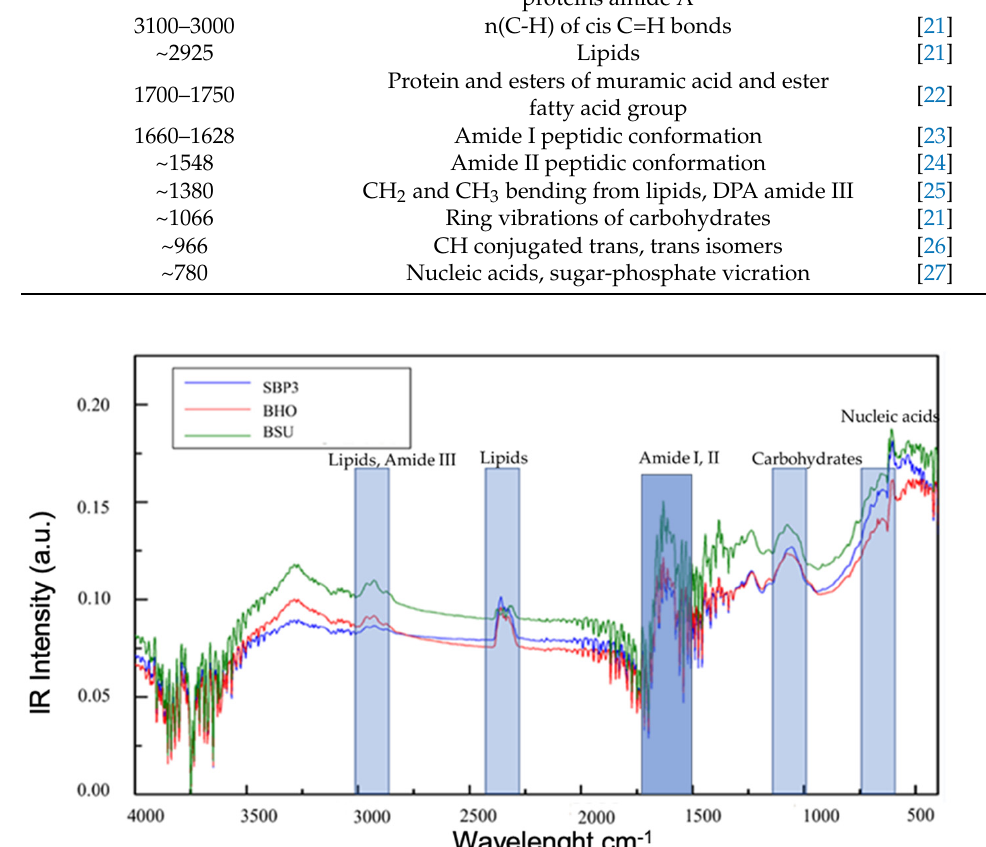
Figure 2. FTIR spectra of spores from B. horneckiae SBP3 (SBP3), B. horneckiae DSM23495 T (BHO) and B. subtilis 168 (BSU).